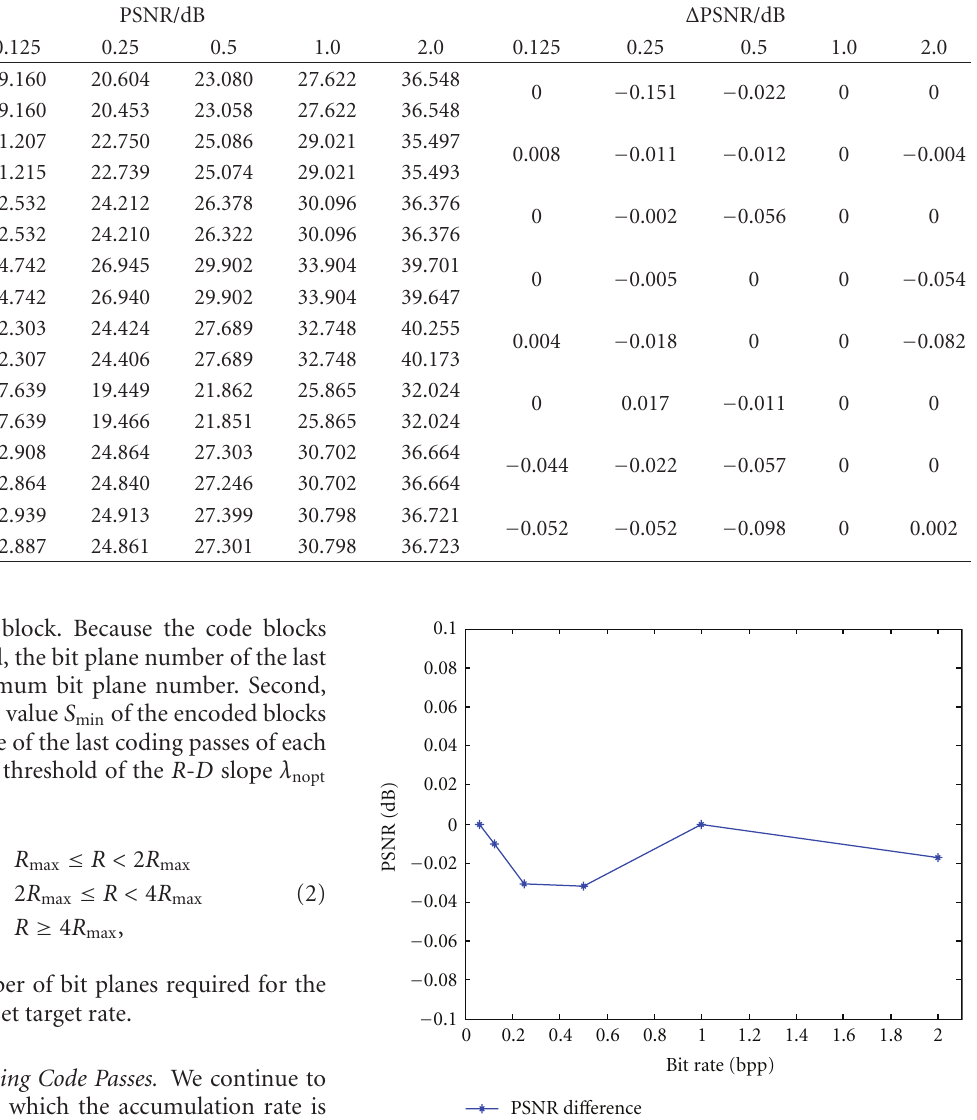
Figure 1: Average PSNR di ff erence between the PCRD and proposed